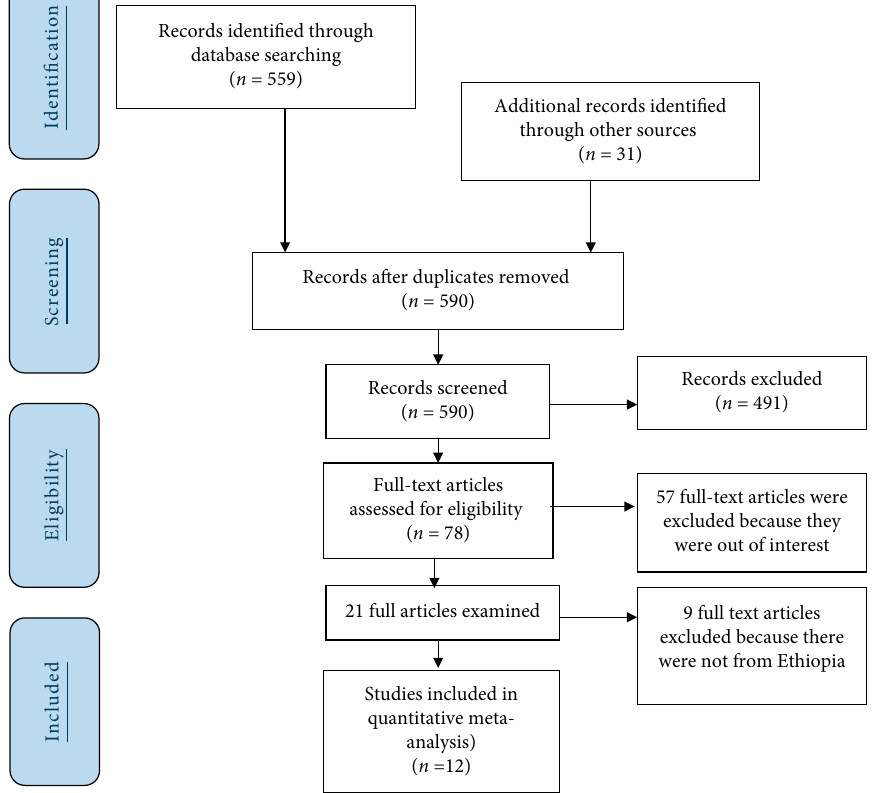
Figure 1: Flowchart to a selection of studies for a systematic review and meta-analysis of the prevalence of compliance to iron-folic acid supplementation and its association with a number of ANC visit in Ethiopia,